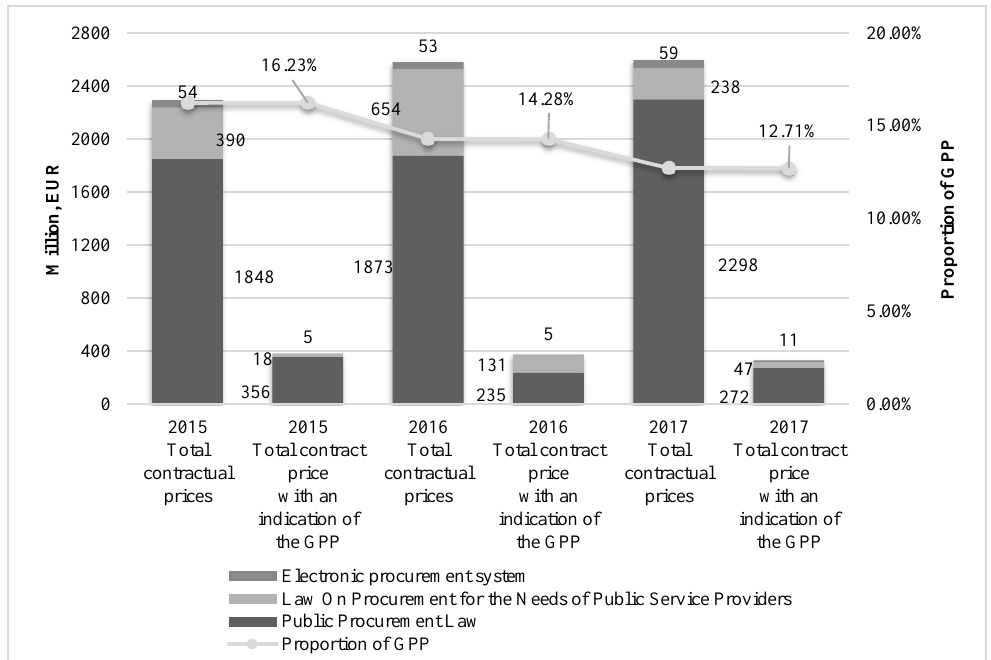
Fig. 1. Proportion of GPP in procurement performed by PPL, LPNPSP and EPS